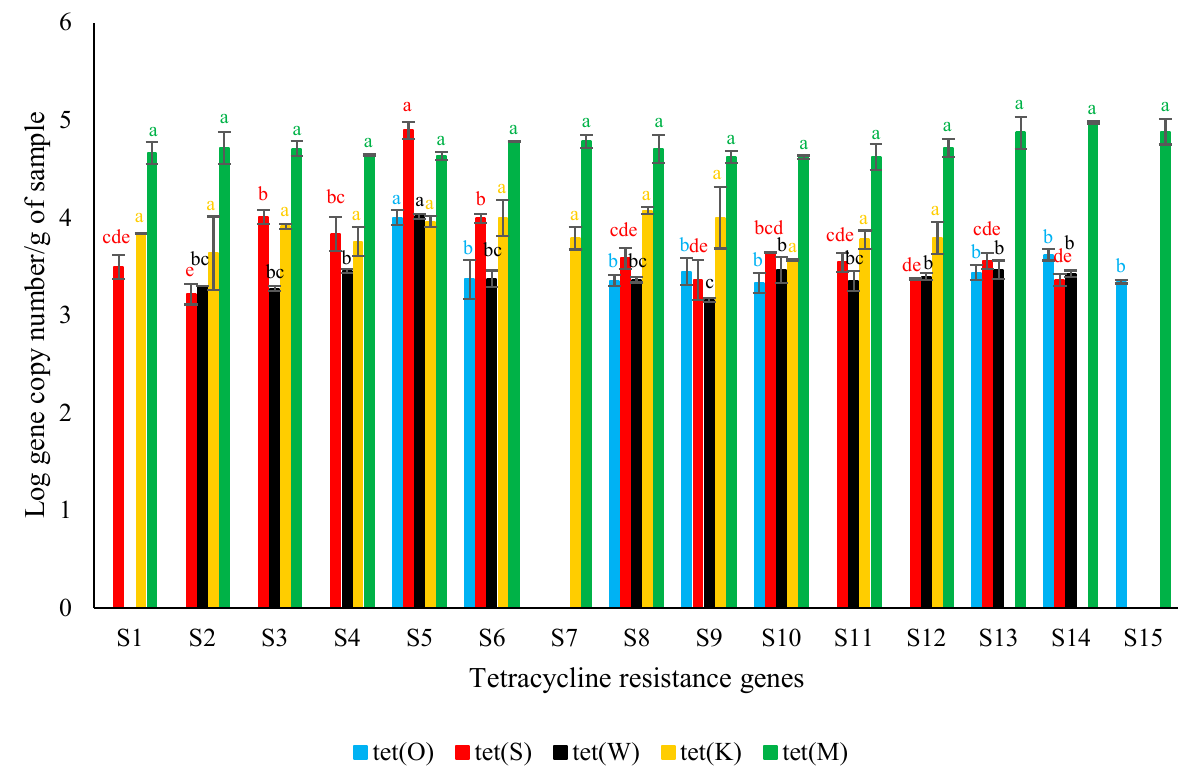
Figure 1. Average tetracycline resistance genes’ Log copy numbers per g of surströmming sample (S1–S5 (producer A), S6–S10 (producer B), and S11–S15 (producer C)) ± standard deviation. For each target gene, different letters indicate significant differences among samples ( p < 0.05).